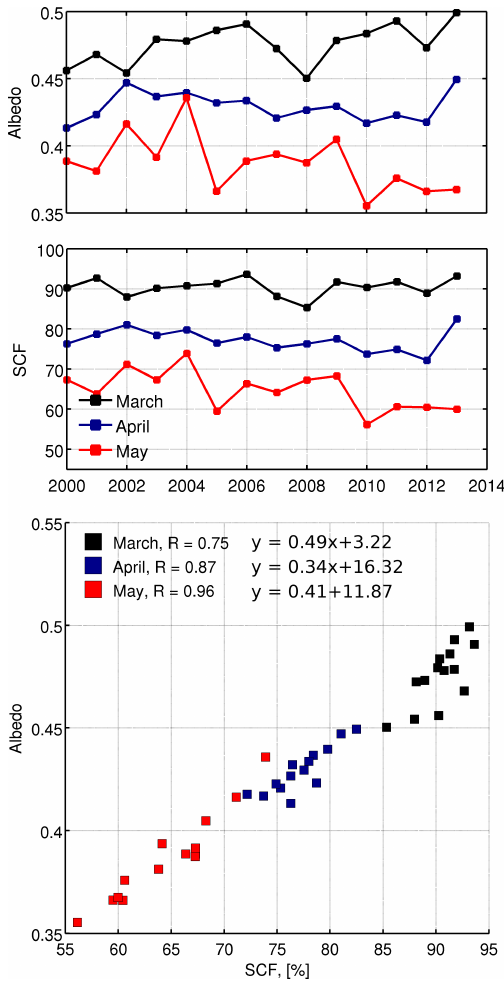
Figure 4. Time series (top panel) and scatter plot (bottom panel) of mean NH 50 domain albedo and SCF for the years